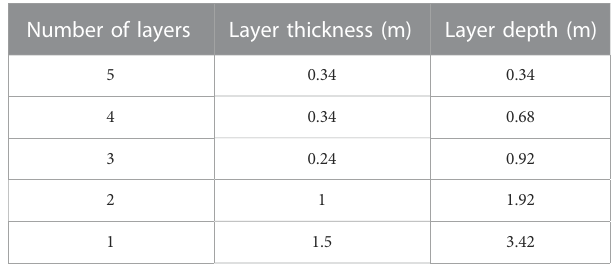
TABLE 1 Vertical layers.